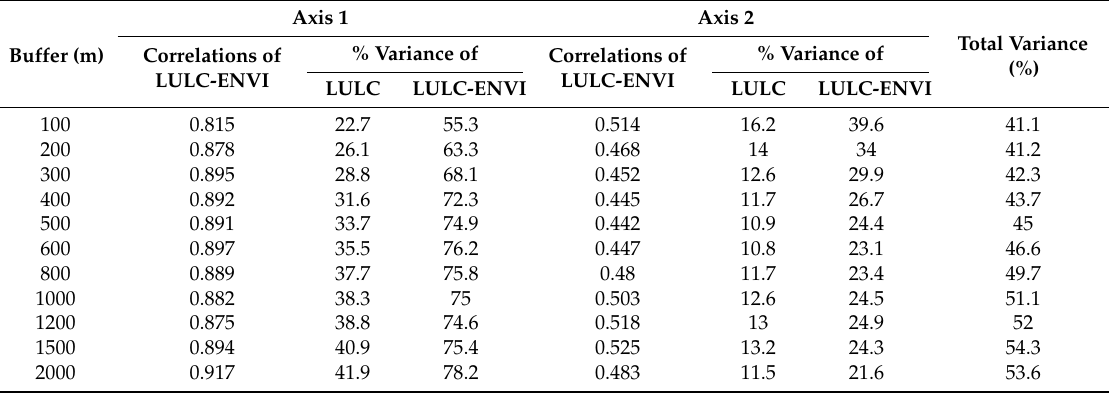
Table 2. Summary of RDA of LULC with respect to the five environmental variables (ENVI) at buffers of 100–2000